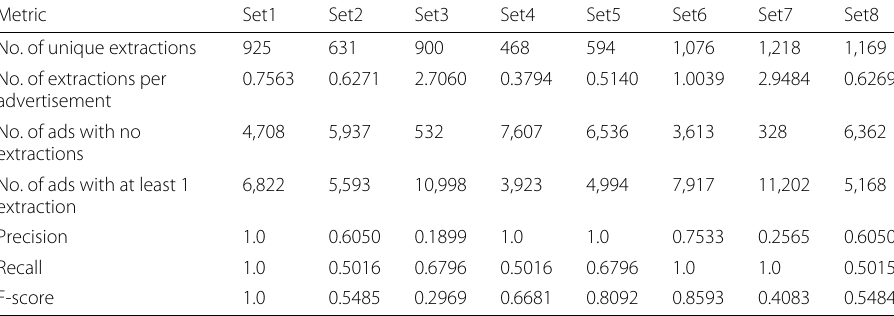
Table 4 Dataset characteristics for name extractions Metric